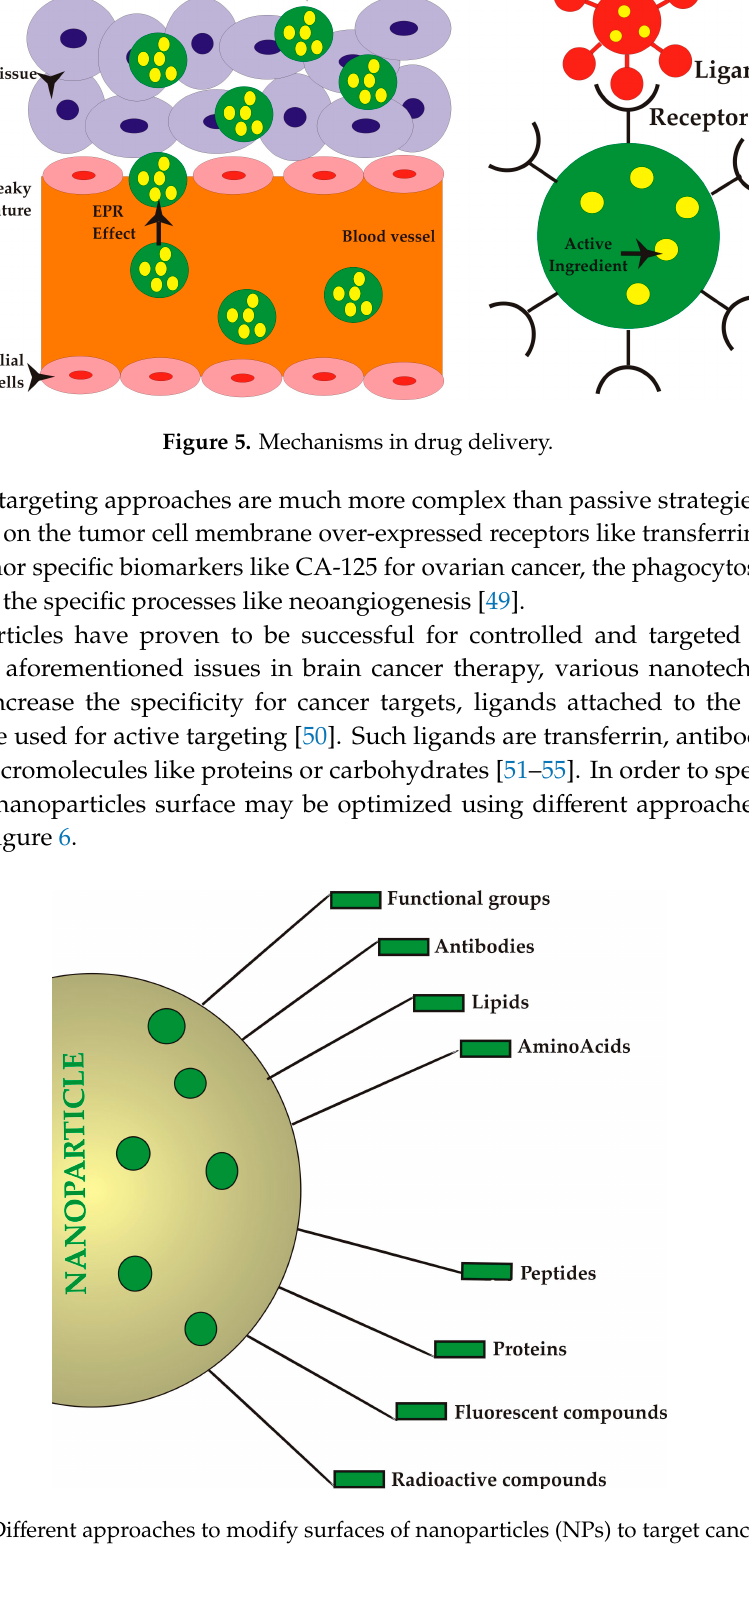
Figure 6. Different approaches to modify surfaces of nanoparticles (NPs) to target cancer